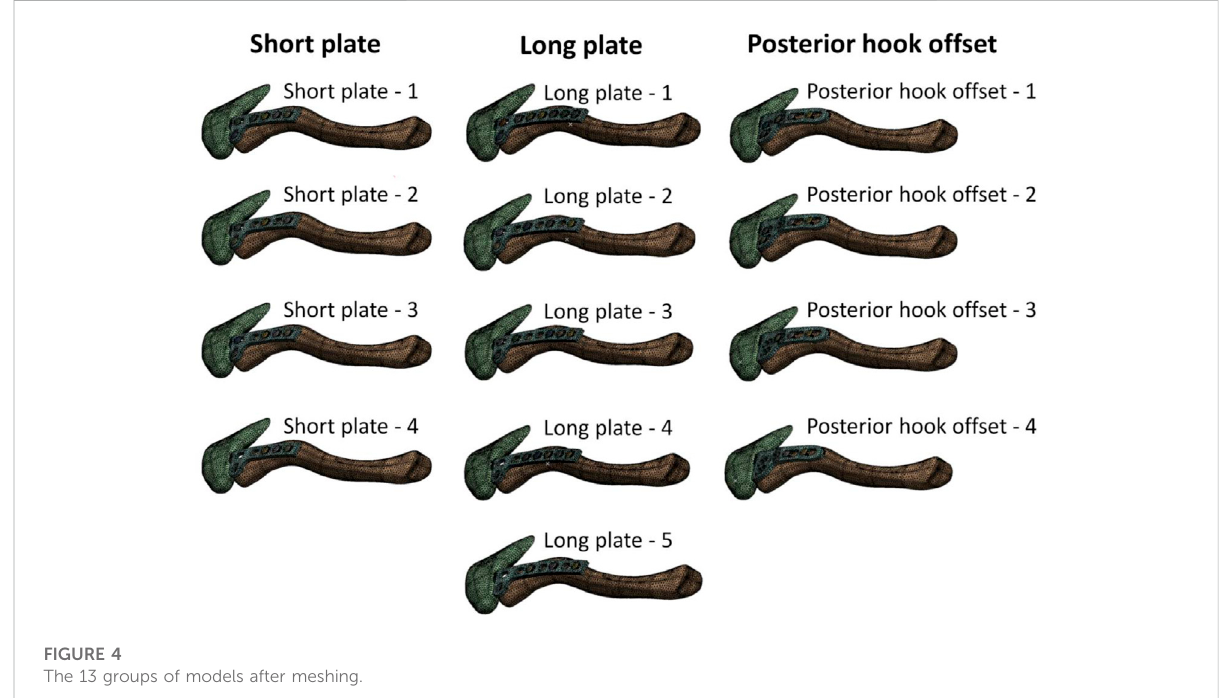
FIGURE 4 The 13 groups of models after meshing.